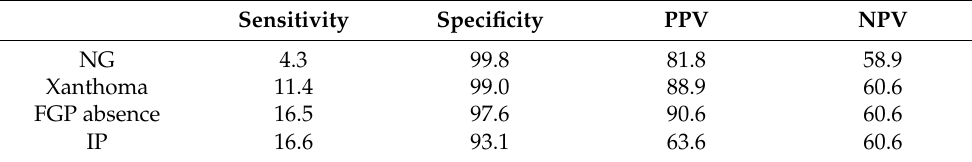
Table 4. Predictivity of factors for H. pylori